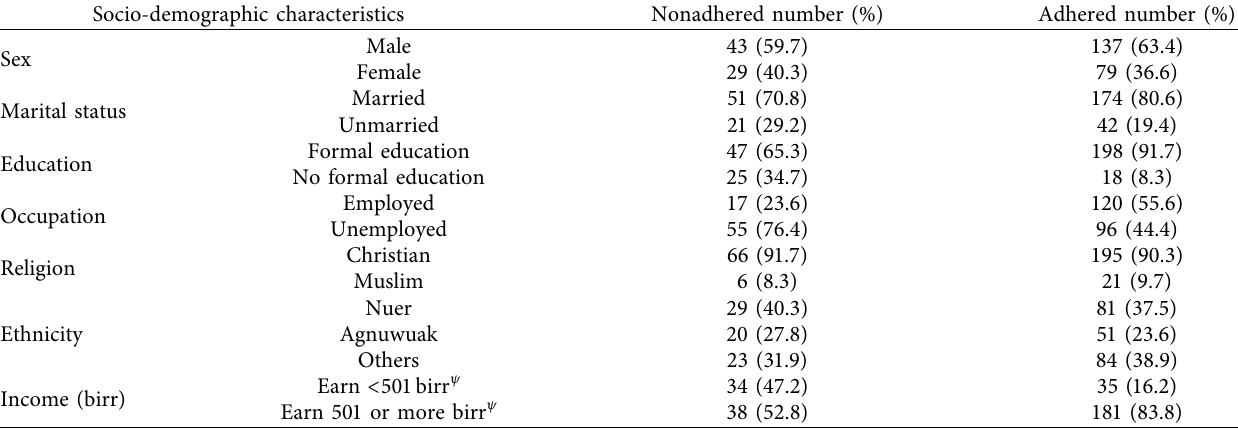
Table 2: Sociodemographic and economic factors among TB patients about TB-drug nonadherence in Gambella region. Socio-demographic characteristics